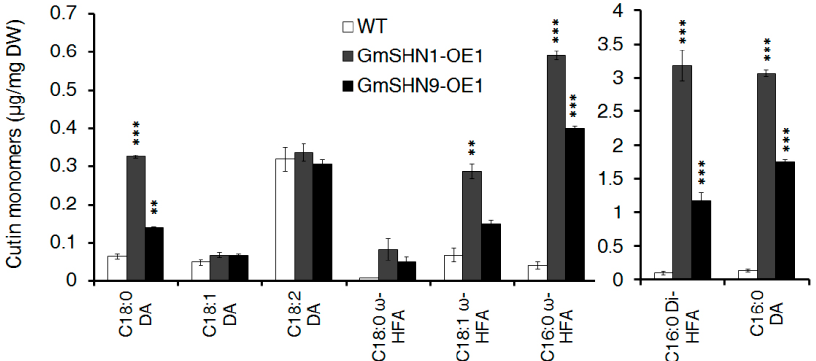
Figure 10. Leaf cutin monomer composition of the GmSHN1-OE1 and GmSHN9-OE1 compared with the WT. DA, dioic acid; HFA, hydroxyl fatty acid; Di-HFA, di-hydroxyl fatty acid. The results are given as mean values and error bars means SD ( n = 3). Significance levels between GmSHN1-OE1, GmSHN9-OE1, and WT were assessed by Student’s t test (* p < 0.05, ** p < 0.01, *** p <